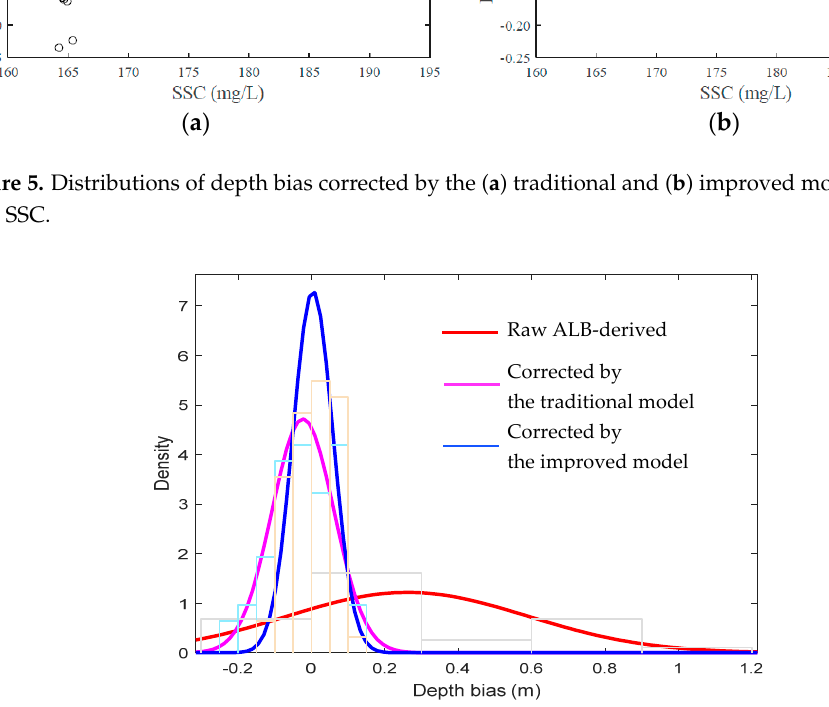
Figure 6. Probability density function curves of the depth biases: raw ALB-derived, corrected by the traditional depth bias model, and corrected by the improved depth bias model.